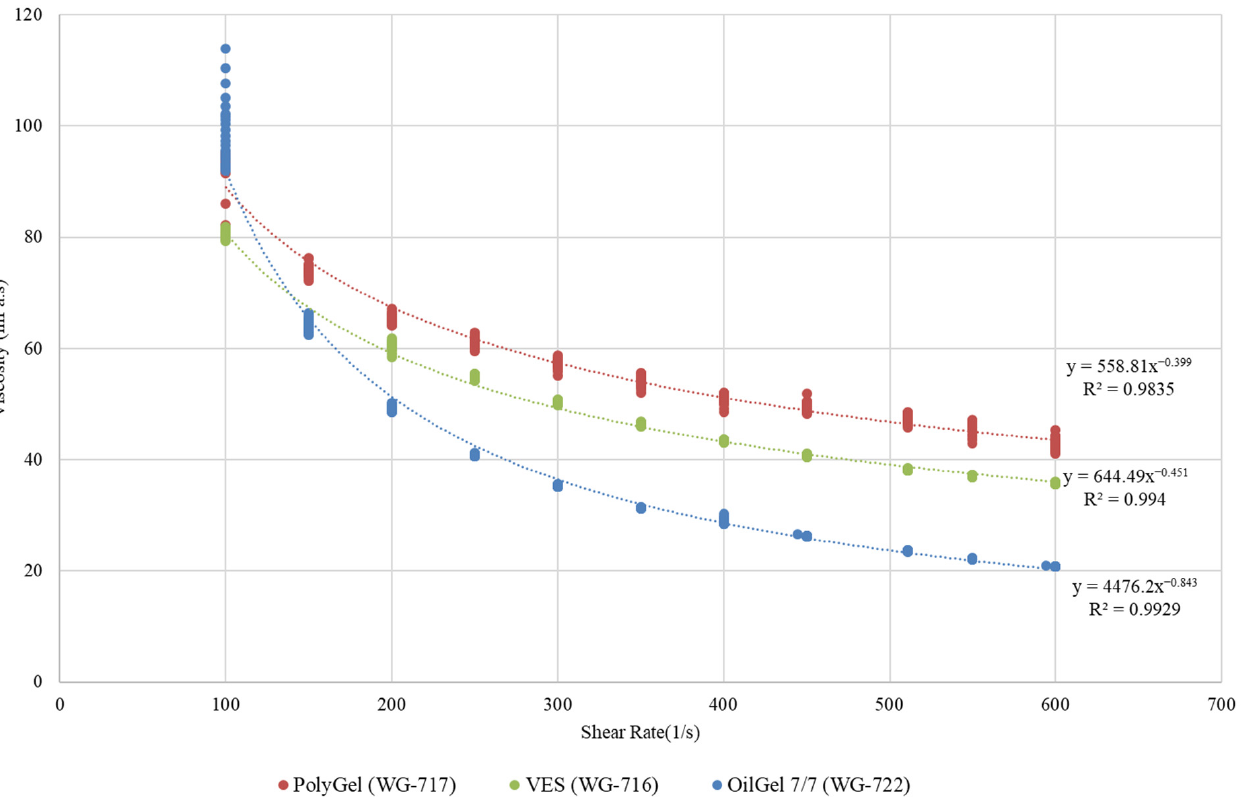
Figure 6. Viscosity as the function of shear rate for water-based fluids and low viscose oil-based fluid.